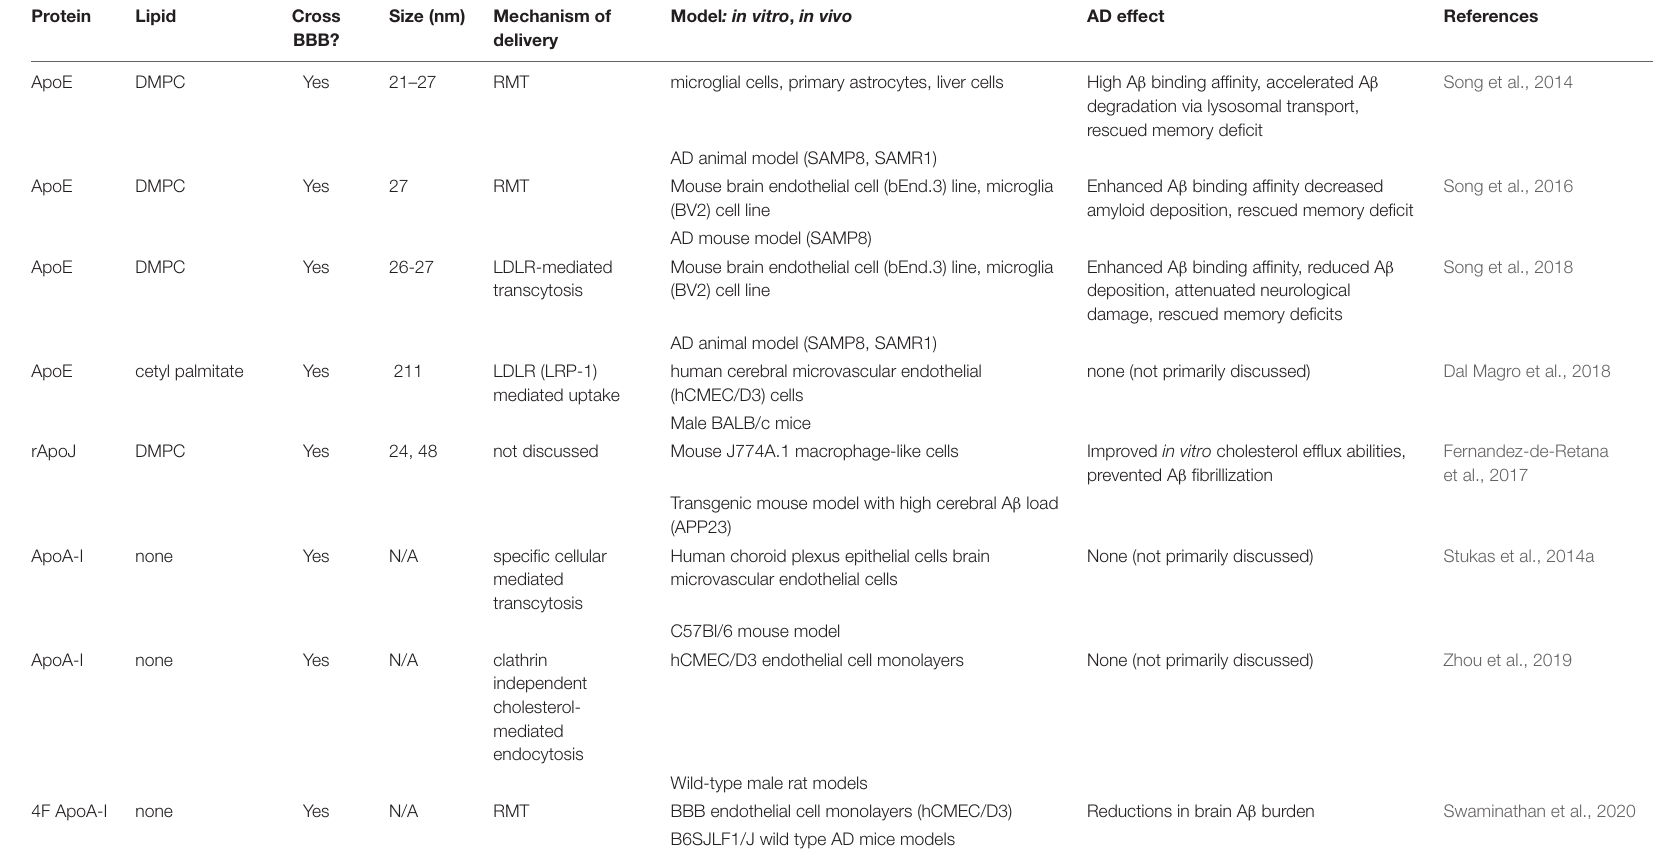
RMT, receptor-mediated transcytosis; RME, receptor-mediated endocytosis; LDLR, low-density lipoprotein